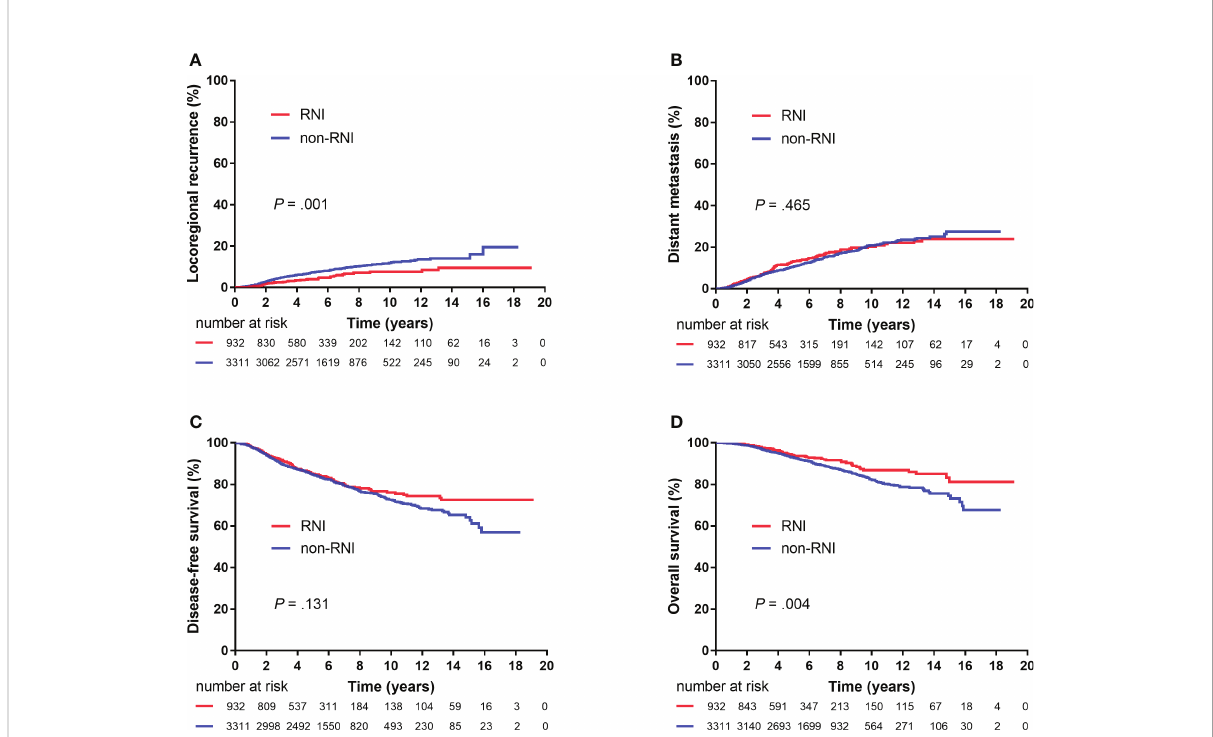
FIGURE 2 Kaplan – Meier plots showing locoregional recurrence (A) , distant metastasis (B) , disease-free survival (C) , and overall survival (D) between the RNI and non-RNI groups (4,243